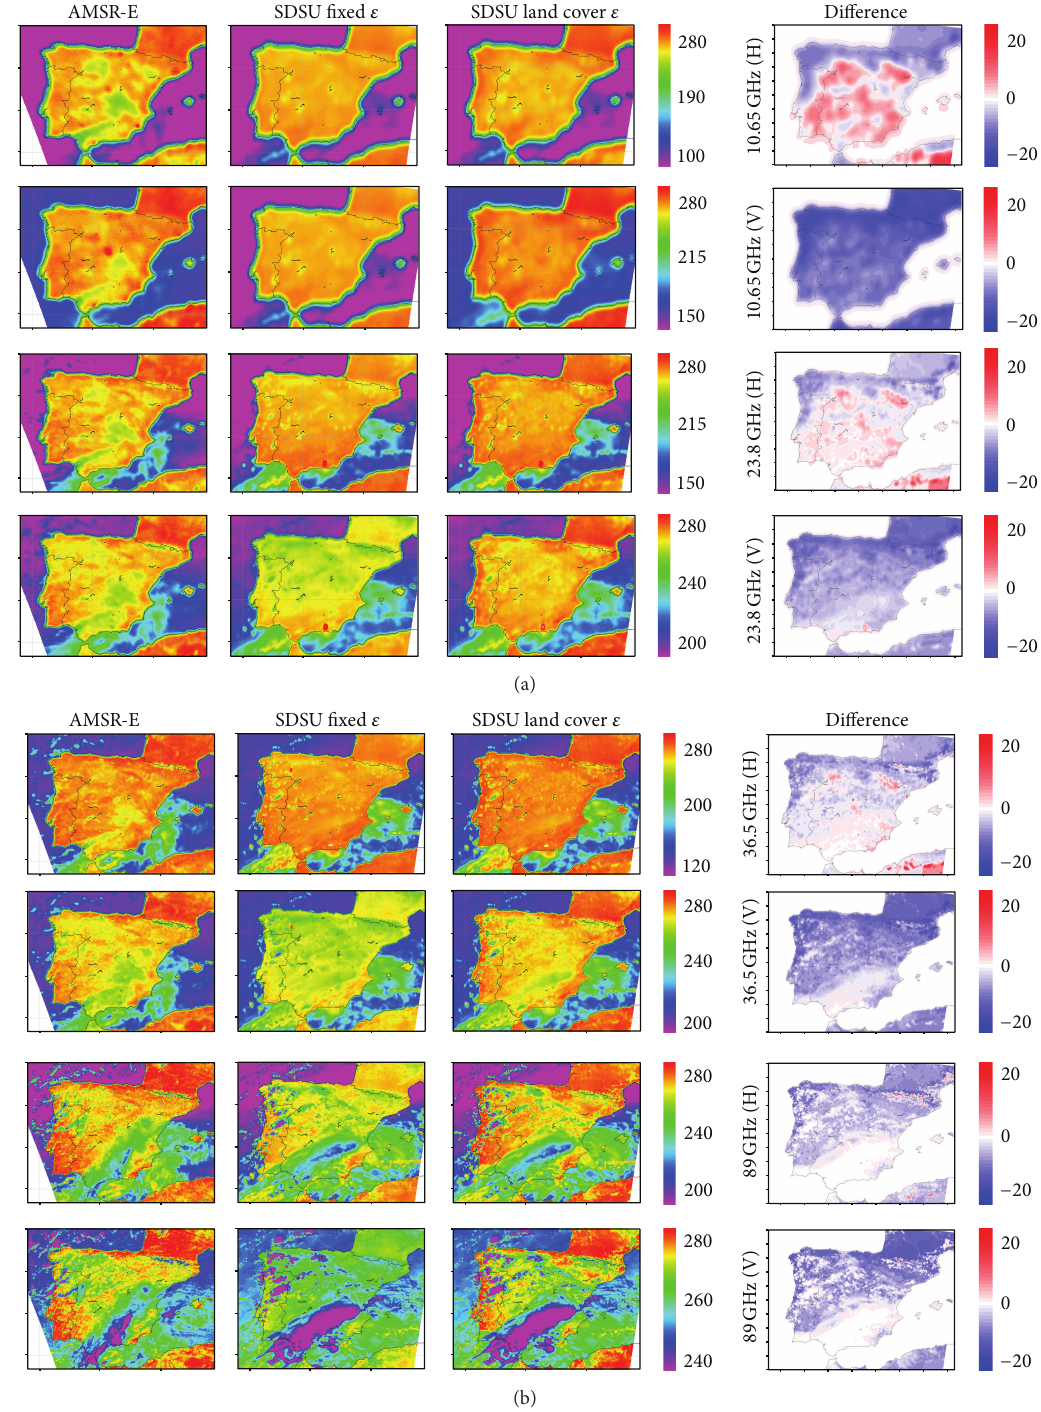
Figure 7: (a) From left to right, upper 2 panels: 𝑇 𝑏 at 10.65 GHz (H-V) for AMSR-E, SDSU (original version), SDSU (emissivity table version), and differences between the two versions (values in K). Down 2 panels: 𝑇 𝑏 at 23.8 GHz (H-V) for AMSR-E, SDSU (original version), SDSU (emissivity table version), and differences between the two versions (values in K). All images are for the case of 15 February 2011. (b) From left to right, upper 2 panels: 𝑇 𝑏 at 36.5 GHz (H-V) for AMSR-E, SDSU (original version), SDSU (emissivity table version), and differences between the two versions (values in K). Down 2 panels: 𝑇 𝑏 at 89GHz (H-V) for AMSR-E, SDSU (original version), SDSU (emissivity table version), and differences between the two versions (values in K). All images are for the case of 15 February